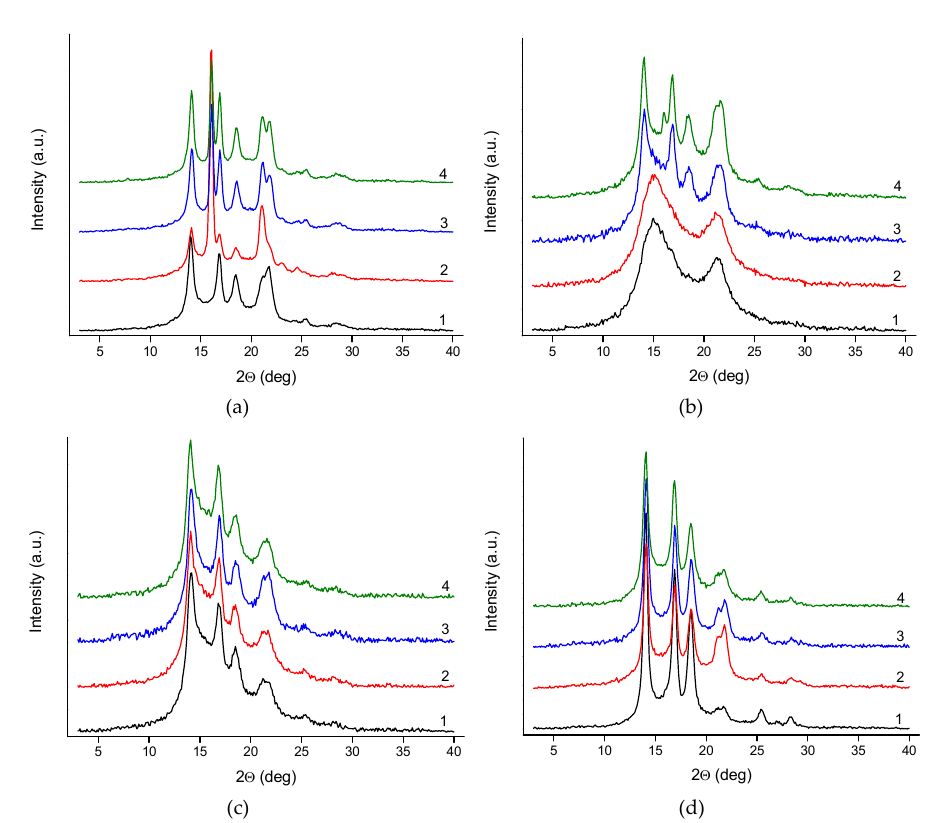
Figure 7. Wide-angle X-ray scattering (WAXS) patterns of polypropylene fibers: ( a ) gravity spun; fibers taken at ( b ) 50 m/min; ( c ) 200 m/min; ( d ) 800 m/min. In the drawings, black curves (1) refer to fibers of pure polypropylene, while red (2), blue (3), and green (4) curves refer to fibers of iPP with rGO-CP in the amount of 0.1, 0.5, and 1.0 wt.%, respectively. (The curves were shifted along the intensity axis for clarity).